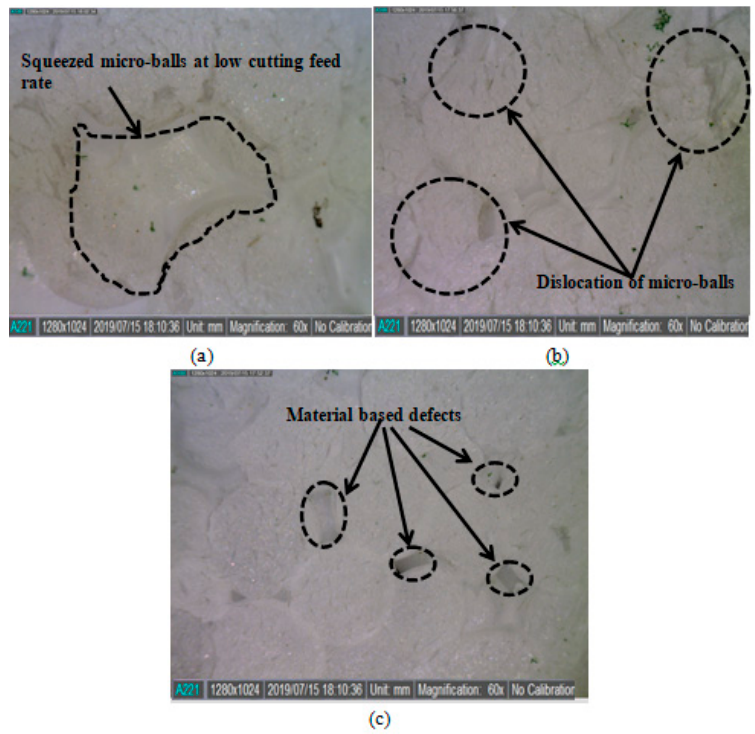
Figure 4. Surface morphology of ( a ) thermal squeezed (at low 30 mm), ( b ) dislocated (at low 30 mm), and (c) precisely machined micro-balls (at 50 mm/min).